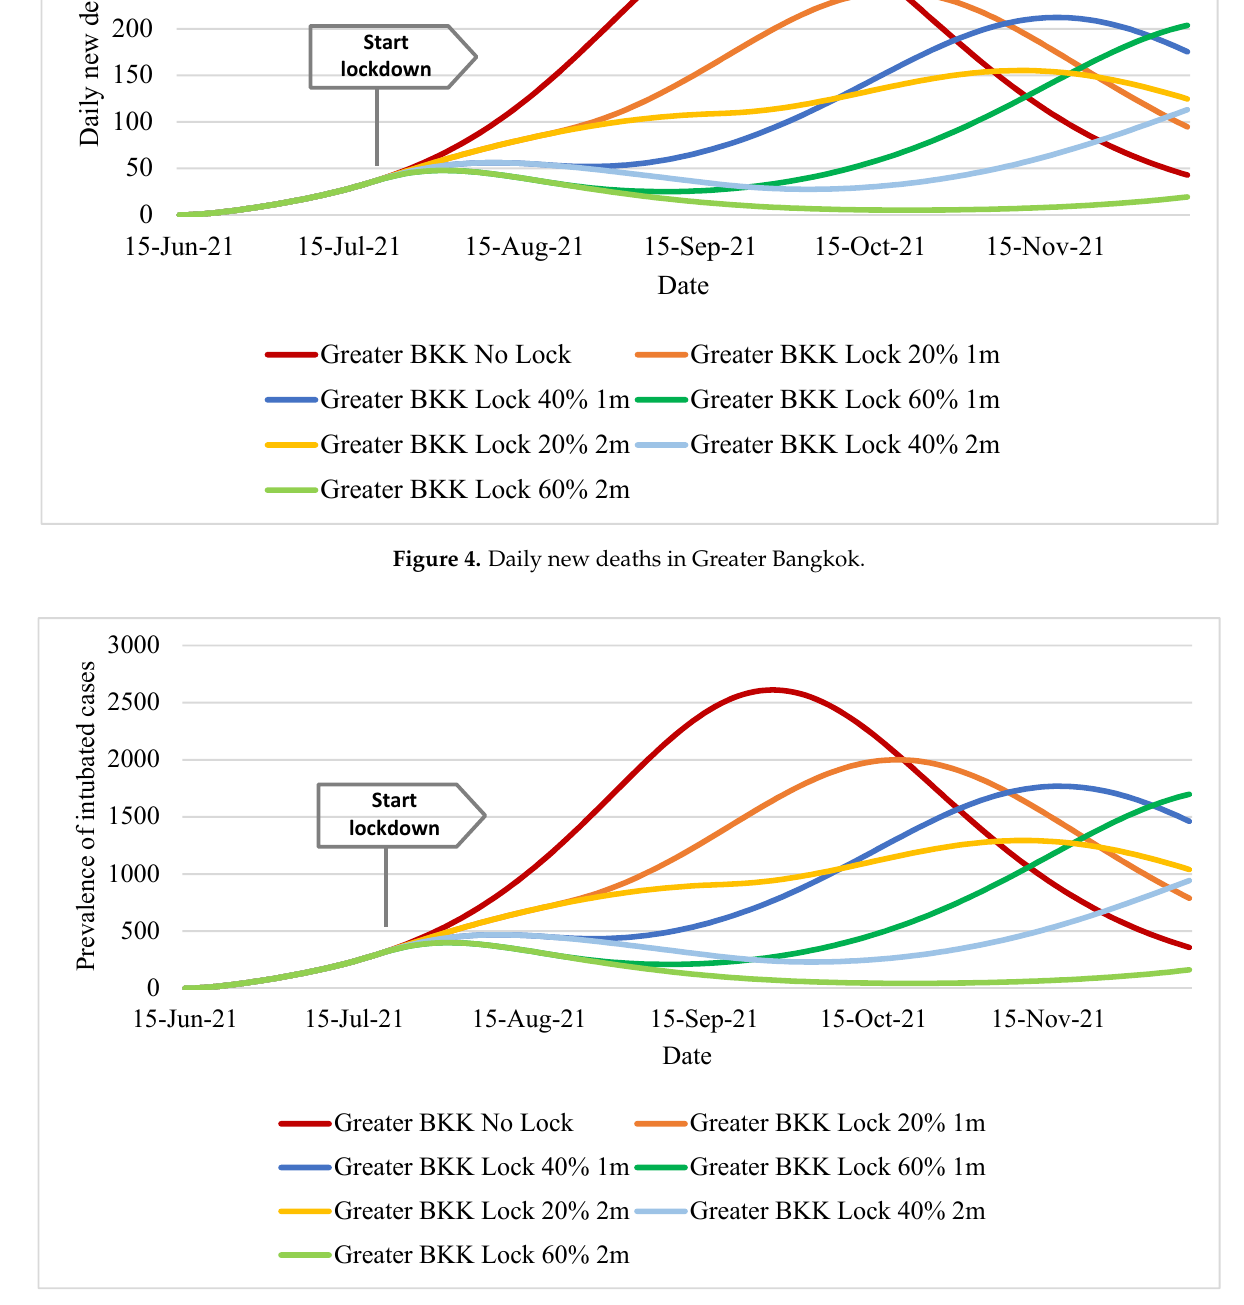
Figure 5. Prevalent reported intubated cases in Greater Bangkok.